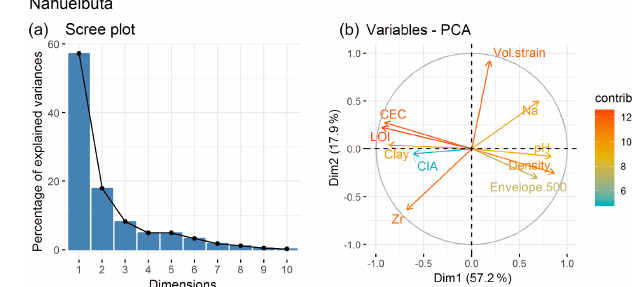
Figure 11. Principal component analysis (PCA) of properties for all four pedons in Nahuelbuta.